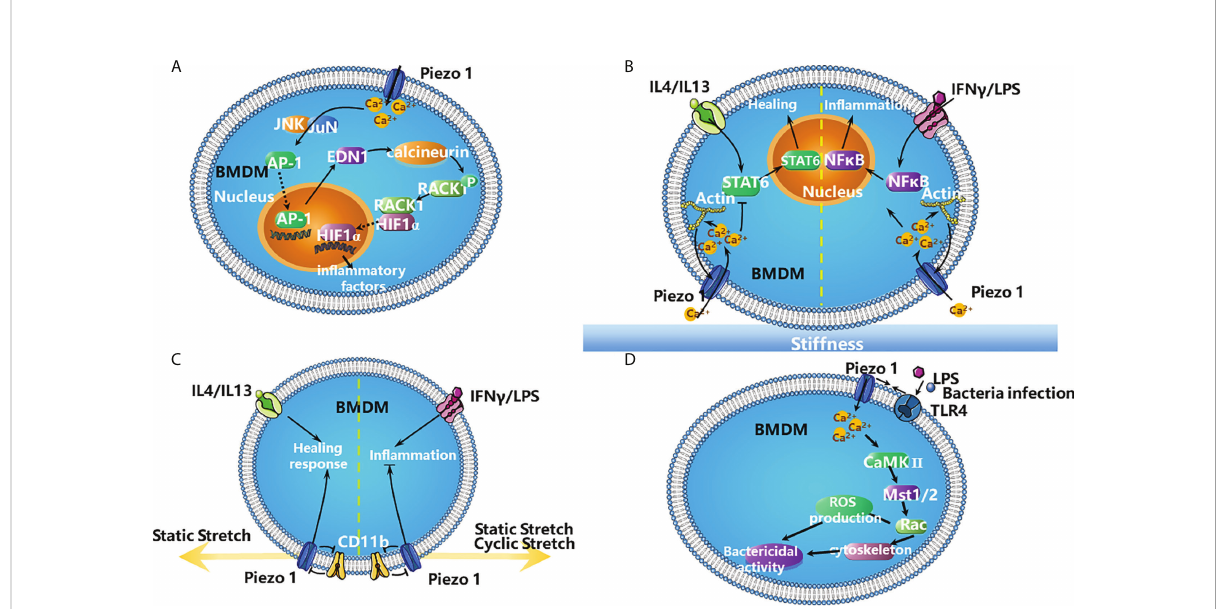
FIGURE 2 The roles of Piezo1 in the in fl ammation. (A) The activation of Piezo1 in BMDMs by mechanical force favors in fl ammation. Mechanical stimulation of BMDM triggers the expression of proin fl ammatory factors via Piezo1. Piezo1 activation increases the concentration of Ca 2+ in the cytosol, which increases the activity of AP-1 and Edn1 production. Edn1 signalling in turn stabilizes HIF1 a by activating calcineurin, which dephosphorylates RACK1. The stabilization of HIF1 a favors the productions of the proin fl ammatory factors (62). (B) Stiffness-dependent modulation of Piezo1 activity regulates polarization responses of BMDMs. Activation of Piezo1 promotes actin polymerization, which enhances channel mediated Ca 2+ in fl ux. It promotes IFN g /LPS-induced in fl ammation via NF k B and suppresses IL4/IL13-induced healing responses by STAT6 in BMDMs (63). (C) Piezo1 works with integrins to modulate macrophage in fl ammatory and healing responses. Both static and cyclic stretch suppresses IFN g /LPS induced in fl ammation. In contrast, IL4/IL13 mediated healing responses are enhanced with static stretch conditions. Knock down of either CD11b or Piezo1 abrogates these stretch-mediated changes in in fl ammatory responses. In addition, there is crosstalk between CD11b and Piezo1, knock down of CD11b enhances the expression of Piezo1, and conversely knock down of Piezo1 enhances CD11b expression (64). (D) TLR4 signalling augments macrophage bactericidal activity through Piezo1. Bacterial infection or LPS induces the assembly of Piezo1 and TLR4, these changes increase the ability of macrophages to destroy bacterial via producing more ROS and